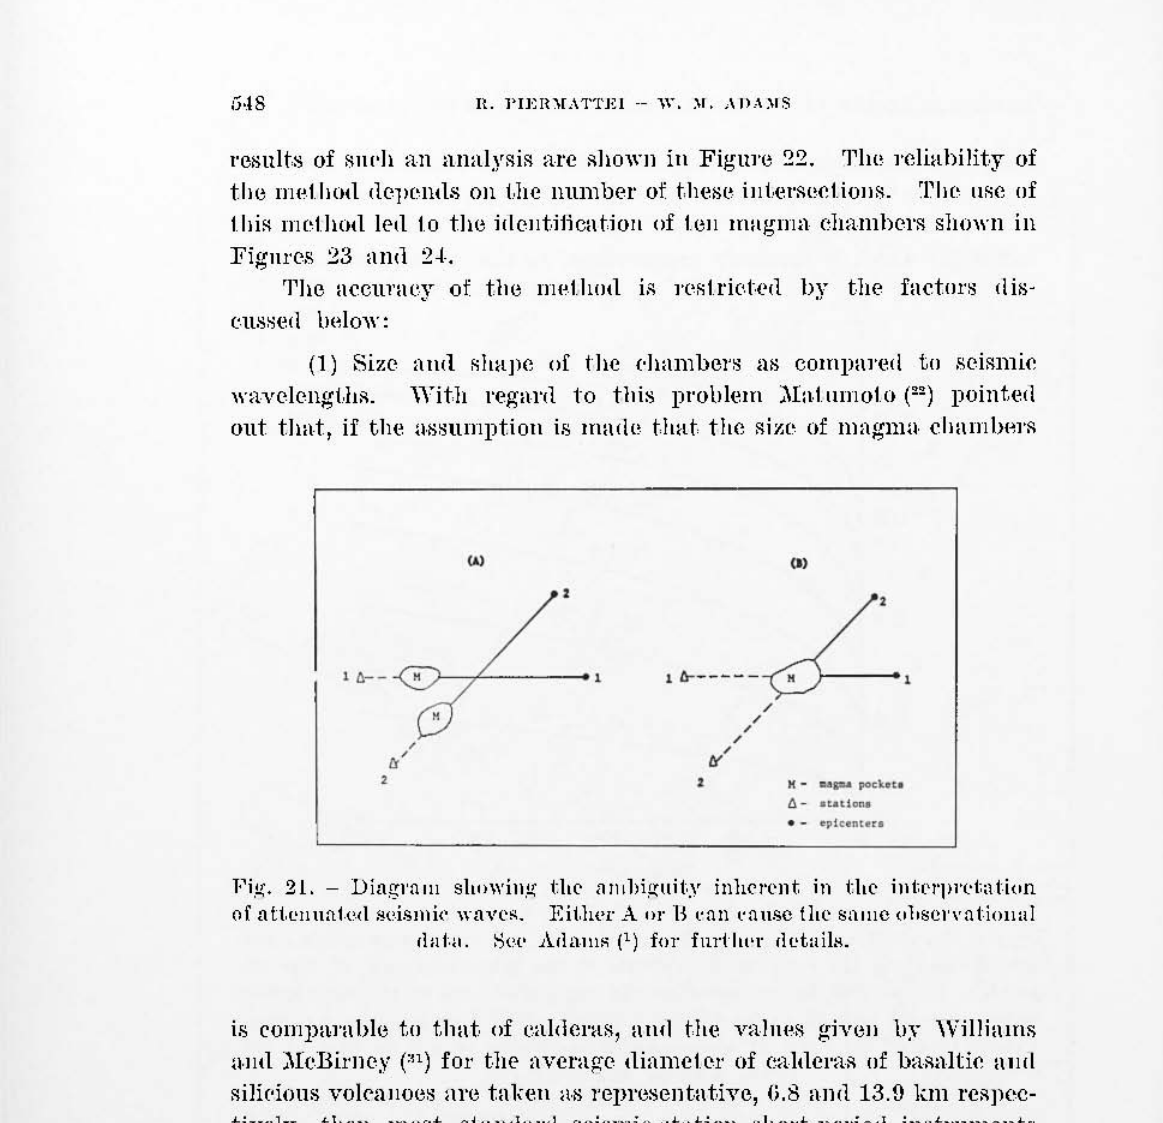
Figure 25 givefi I,he relat.ive am])lilll(le of dillractm! wnves behilId a spherieal